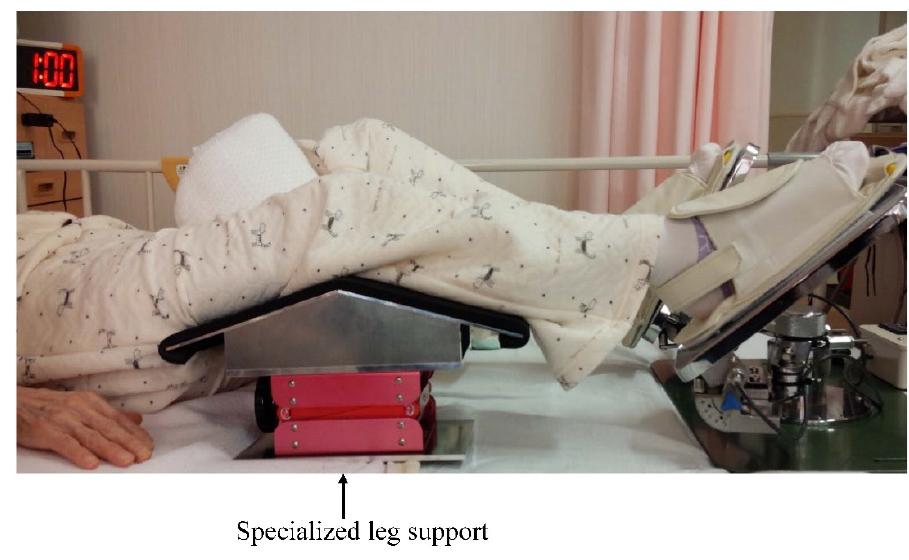
Figure 2. Exercise position using the leg exercise apparatus with a specialized leg support.